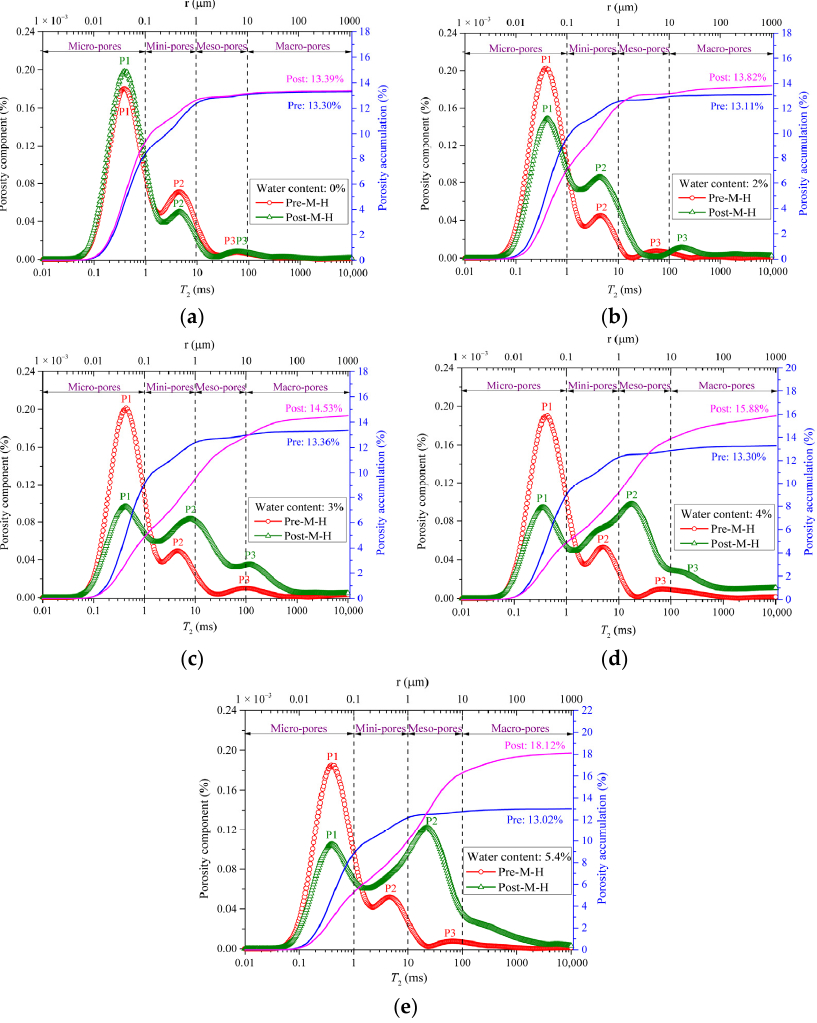
Figure 11. T 2 spectrum: pore size distribution and porosity accumulation curves of the sandstone samples. ( a ) w = 0%, ( b ) w = 2%, ( c ) w = 3%, ( d ) w = 4%, ( e ) w = 5.4%. When the initial water content of the sample continually increases to 4%, the P1 am- plitude continues to decrease, and the P2 amplitude increases significantly, the originally separated local maxima P2 and P3 gradually merge, which means that the increase in in- itial water content is conducive for the connectivity of pores. In addition, when the initial water content of the sample exceeds 4%, the P2 amplitude of the T 2 spectrum exceeds the P1 amplitude, indicating that the pore structure has changed, and the average pore size of the sample has increased compared with that before microwave radiation.